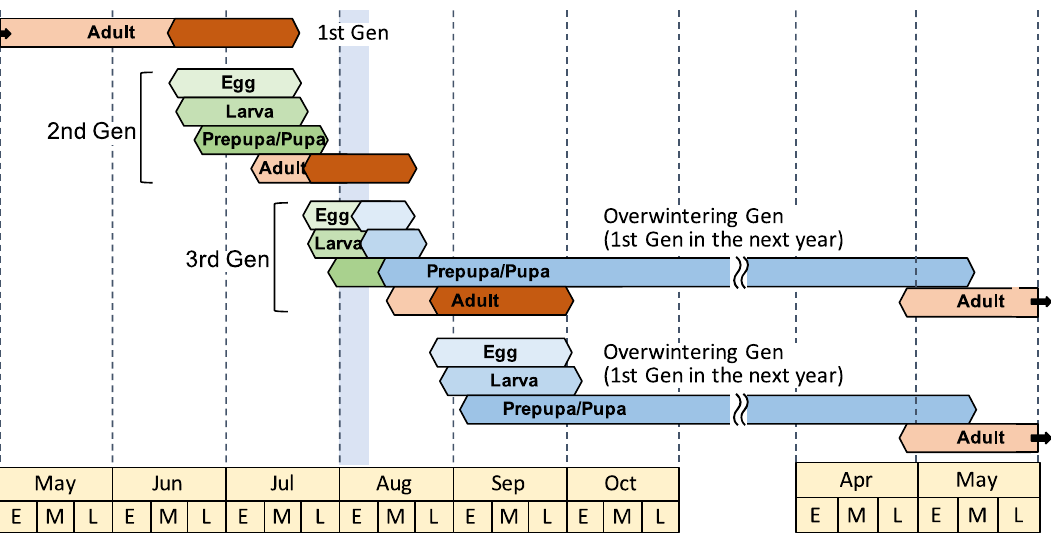
Figure 5. A schematic diagram of the life cycle of Dipogon sperconsus in Takarazuka, Hyogo, Japan. The orange parts of the adult spans represent nesting periods. 1st, 2nd, 3rd and Overwintering Gens represent the first, second, third and overwintering generations in a year, respectively. There is a short critical period during early August (blue area) in which wasps of the third generation would develop into adults either in the summer (summer generation) or in the next spring via diapause of prepupae (overwintering generation). Part of the third generation and almost all of the overwintering generation (deep blue part) become hibernating prepupae, i.e., the wasps exhibited a partial trivoltine life cycle. Because the beginning of nesting activity in the first generation varied according to year, the proportion of adults emerging in the summer to those emerging in